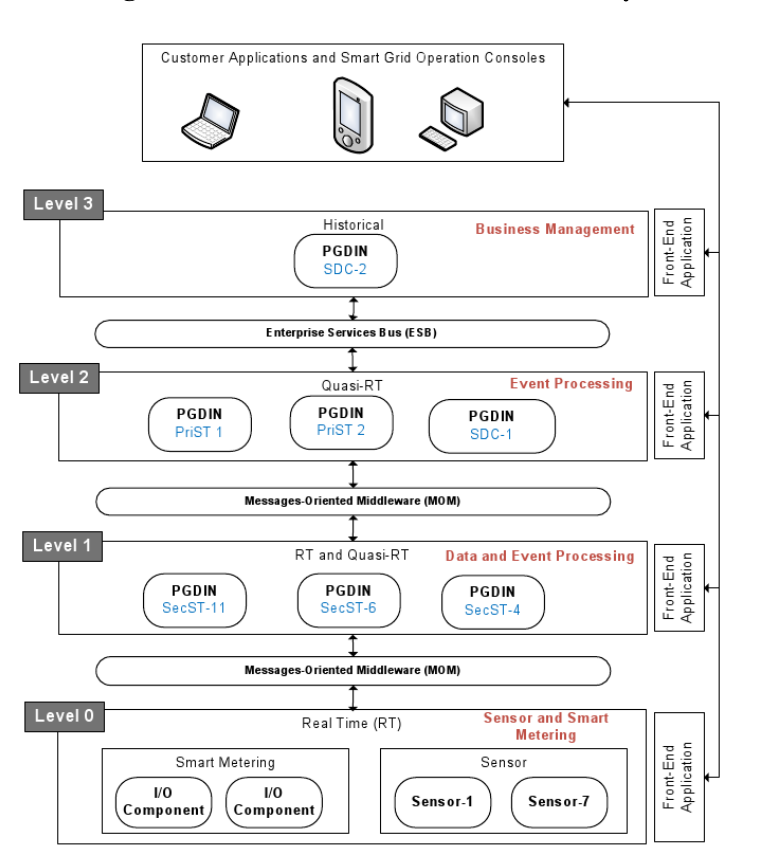
Figure 2. ENERGOS architecture in four